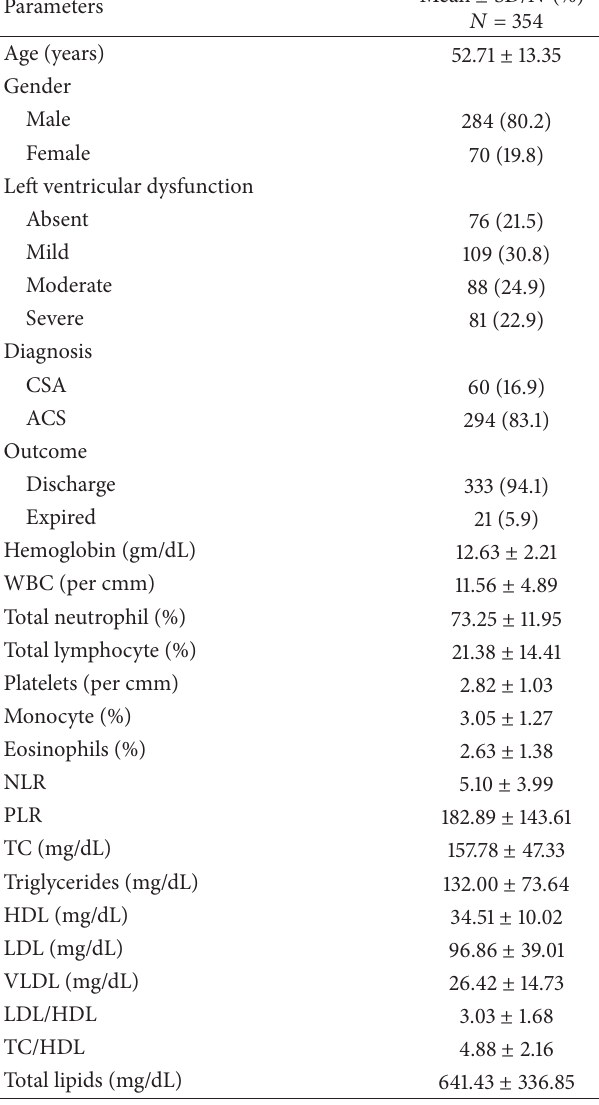
Table 1: Demographic characteristics of the study